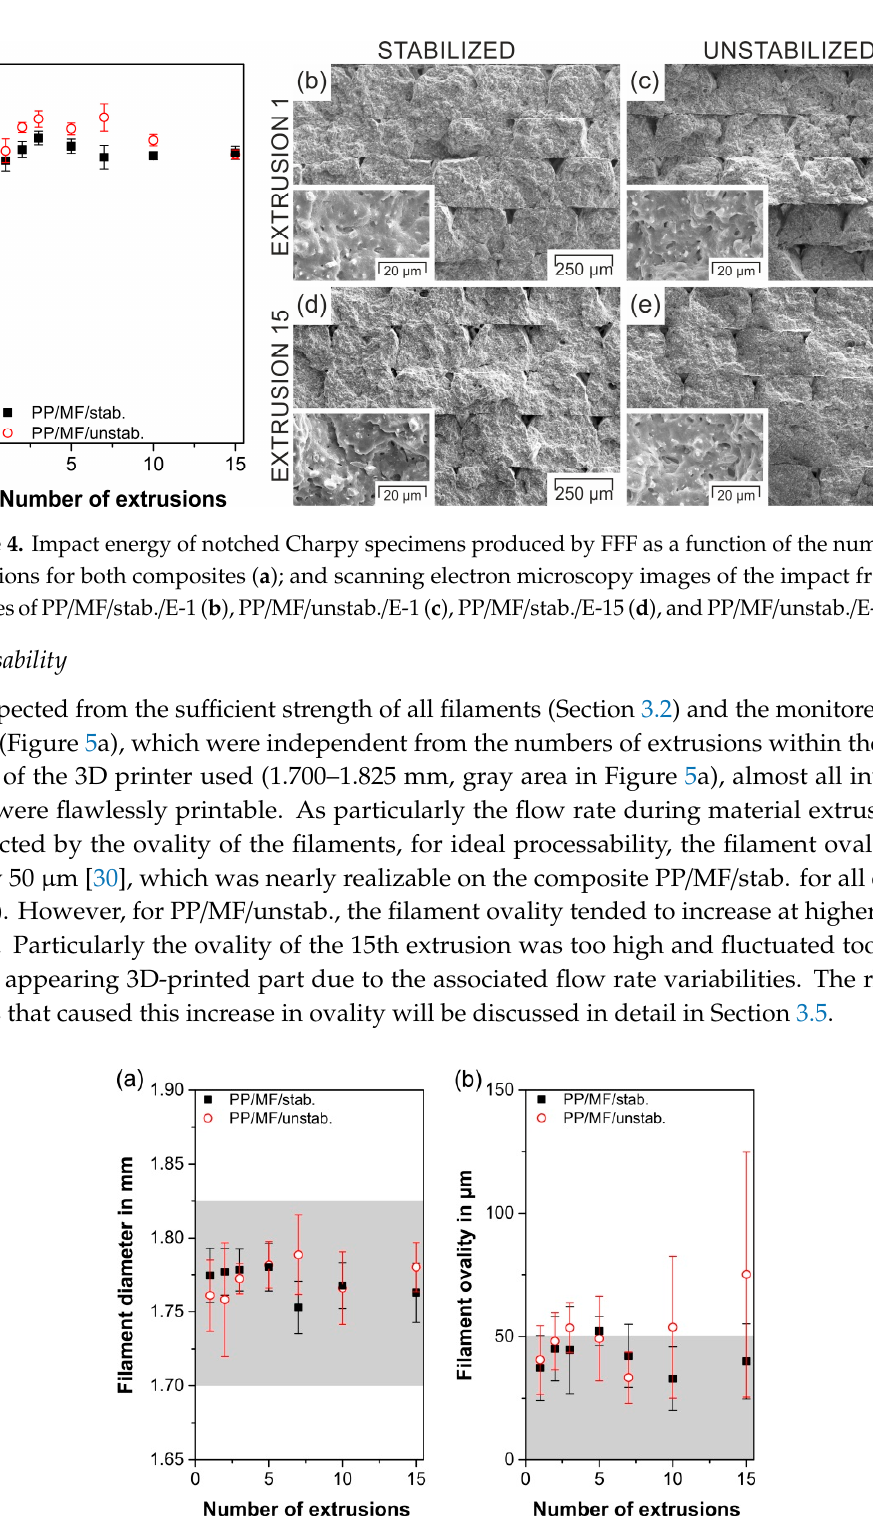
Figure 5. Filament diameter ( a ) and ovality ( b ) as a function of the number of extrusions for both composites. The gray area determines the threshold for a 3D print with decent quality for the 3D-printer used.